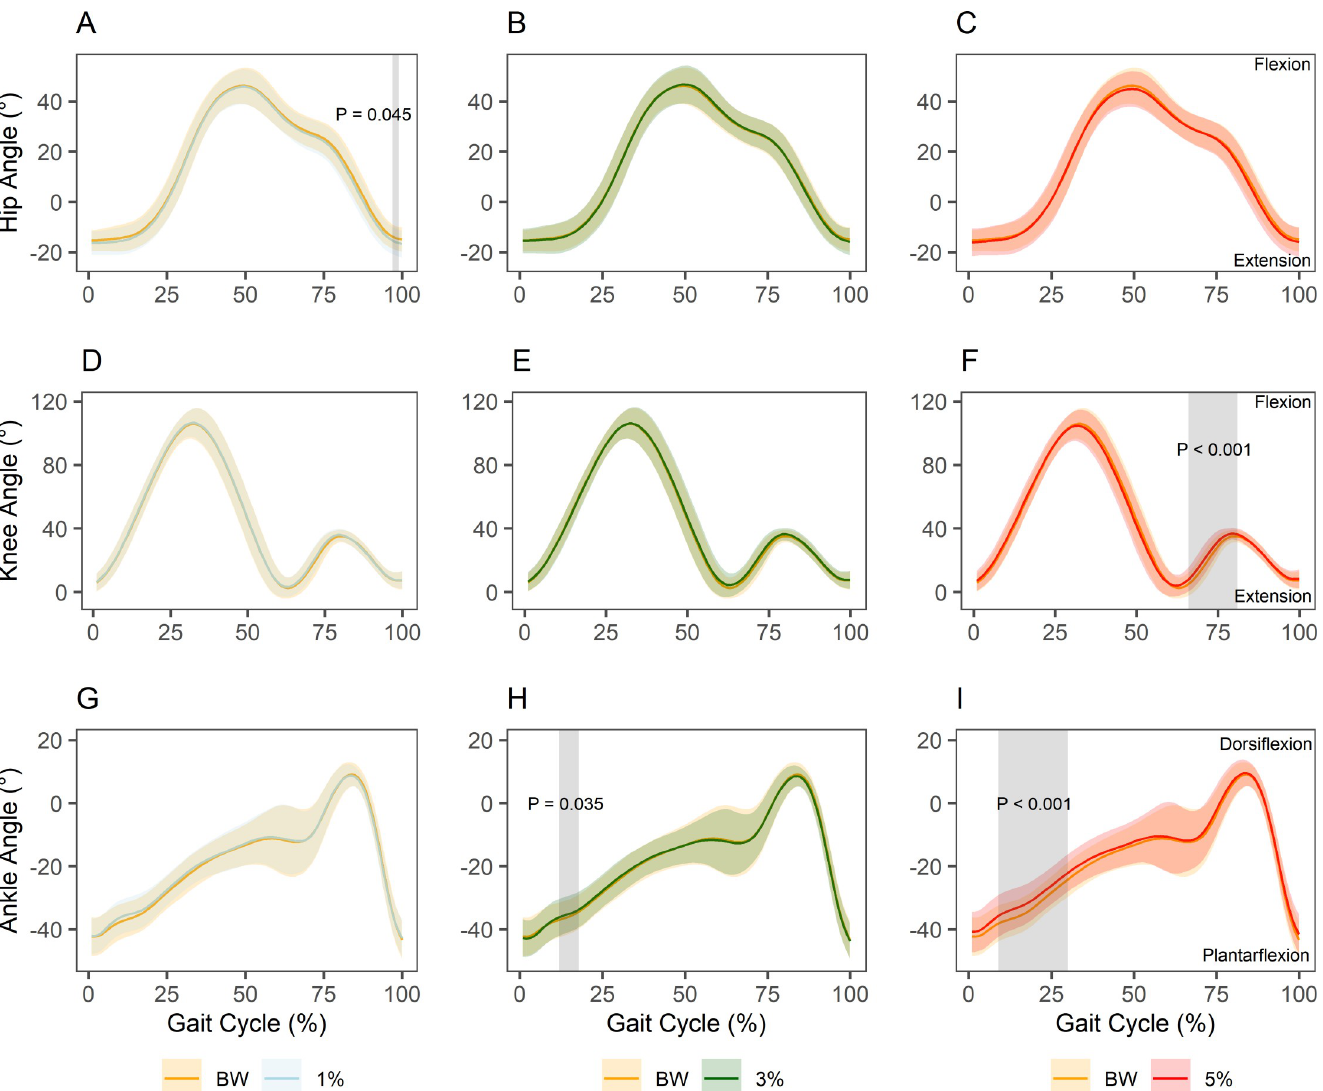
Fig 3. SPM t-test per-joint and per-condition versus BW. (A) Hip joint BW versus 1%. (B) Hip joint BW versus 3%. (C) Hip joint BW versus 5%. (D) Knee joint BW versus 1%. (E) Knee joint BW versus 3%. (F) Knee joint BW versus 5%. (G) Ankle joint BW versus 1%. (H) Ankle joint BW versus 3%. (I) Ankle joint BW versus 5%. Solid lines represent ensemble means and accompanying shaded regions represent ± 1 SD. Grey shaded regions indicate regions of significant difference between curve sets.